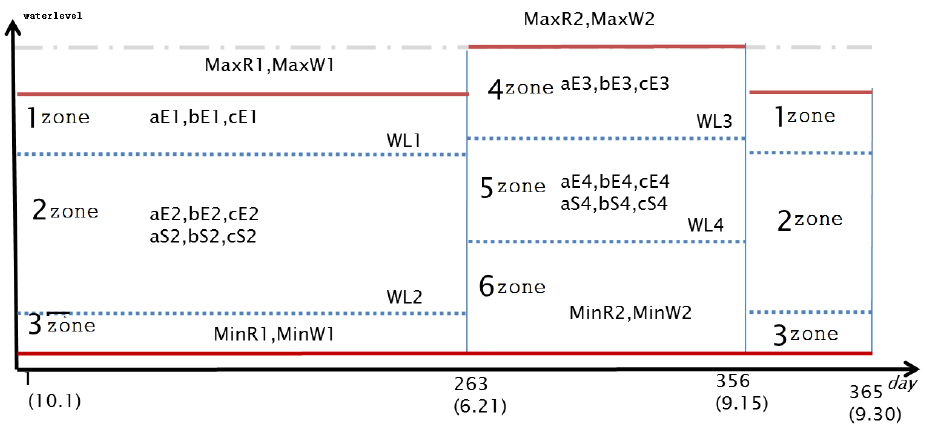
Figure 2. Release functions in different zones characterized by seasons.